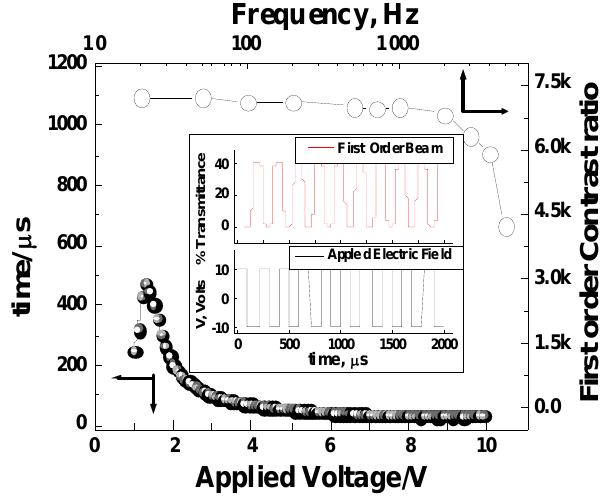
Figure 10. The response time dependence on applied voltage at a driving frequency of 500 Hz (solid legends). The frequency dependence of the first order contrast ratio at the fixed applied voltage at 10 V (open legends). The insertion represents the electro-optical response of the FLC grating cell, the bottom is the applied voltage and the top represents electro-optical response for the first order diffracted beam of wavelength λ = 632 nm at the operational frequency f = 5 kHz [34].